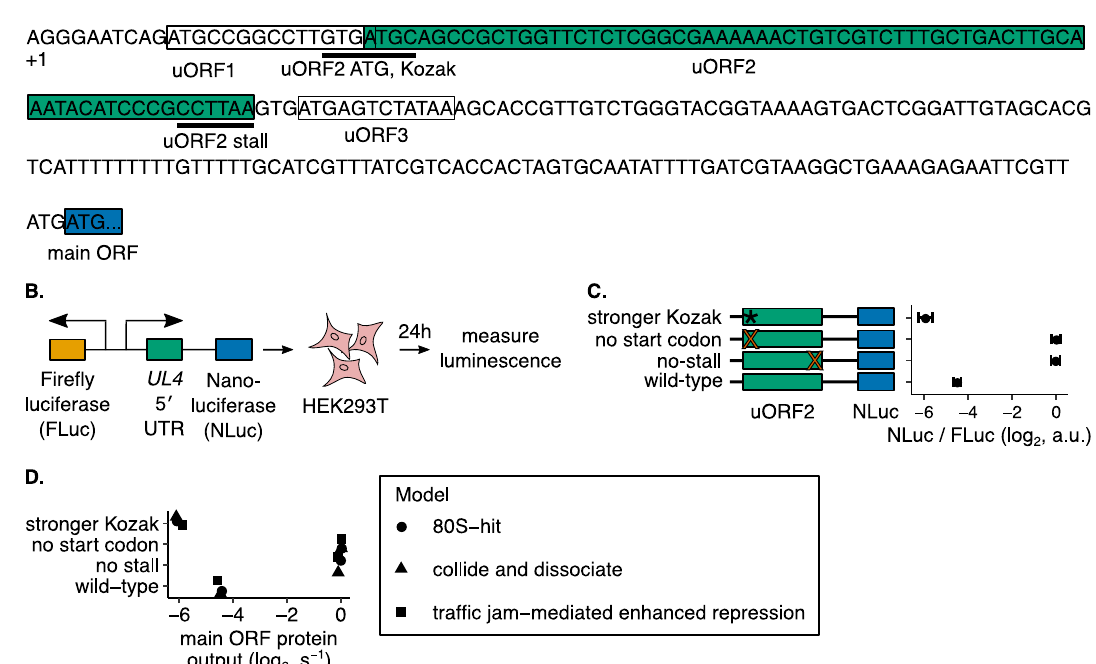
Fig 2. An experimental and computational platform for assessing uORF-mediated regulation of main ORF translation. (A) The 236 nt 5 0 UTR of UL4 mRNA from human cytomegalovirus contains 3 uORFs. The terminal proline and stop codons of uORF2 at which the P- and A-sites of the stalled ribosome are positioned are highlighted as uORF2 stall. (B) A dual-luciferase reporter system for measuring 5 0 UTR repressiveness in HEK293T cells. FLuc signal serves as an internal control for transfection efficiency. (C) The reporter system recapitulates the known elongating ribosome stall-dependent repression of protein expression by the UL4 uORF2 [21]. The indicated mutations improve the uORF2 Kozak context (ACCATGG instead of GTGATGC), remove the start codon (ACC instead of ATG), or remove the elongating ribosome stall by mutating the terminal proline codon to an alanine codon (GCT instead of CCT). Error bars show standard error of mean NLuc / FLuc ratios over 3 biological replicates. Data are normalized to the no-uORF start codon control. (D) Computationally predicted uORF regulation in the 80S-hit dissociation, queuing-mediated enhanced repression, and collision-mediated 40S dissociation models. Data are normalized to the no-uORF start codon control. The parameter combination that best recapitulated the control behavior in Fig 2C is displayed in Table 1. Error bars for simulated data are smaller than data markers.